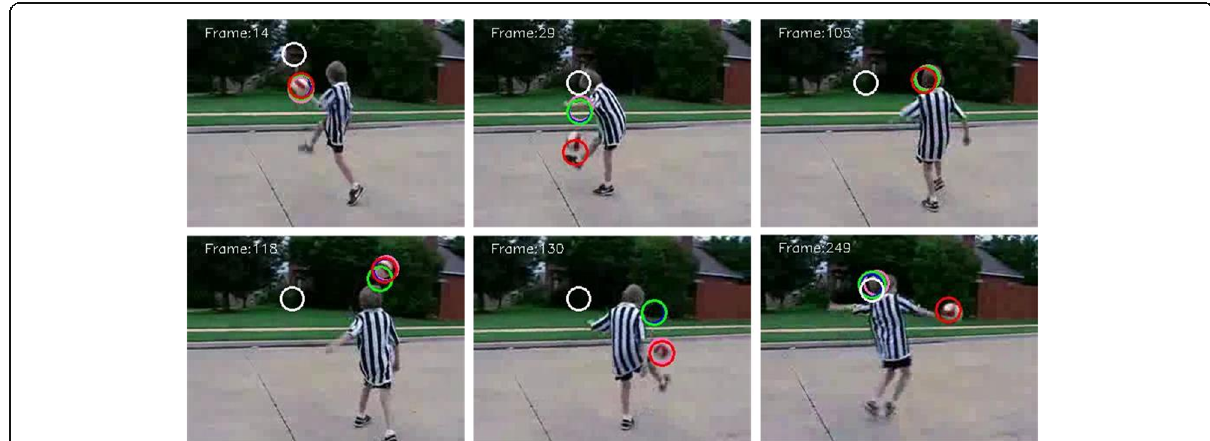
Fig. 17 The tracking results for the video “ v_juggle_11_06 ” using CAM-Shift (white), PF (blue), VAPF (green), M-PF (pink), and the proposed tracker (red). Particle number N = 200